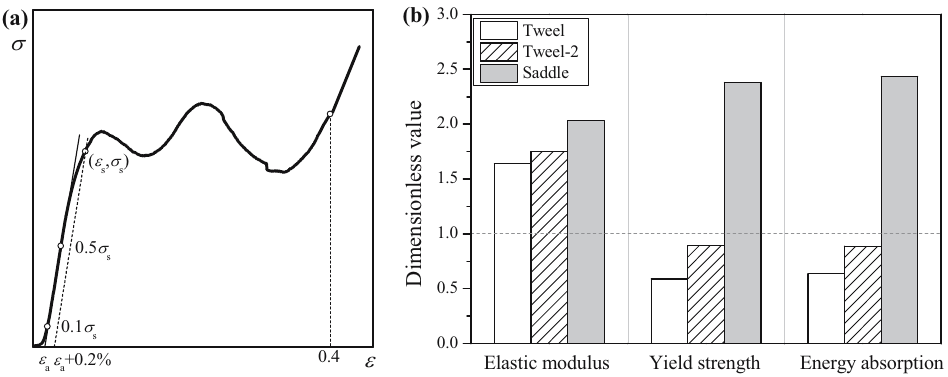
Figure 7: Characterization parameters of the vertical bearing capacity and energy absorption performance of the nonpneumatic tire samples. ( a ) Schematic diagram of parameter calculation and ( b ) experimental results normalized to the values of the honeycomb tire.